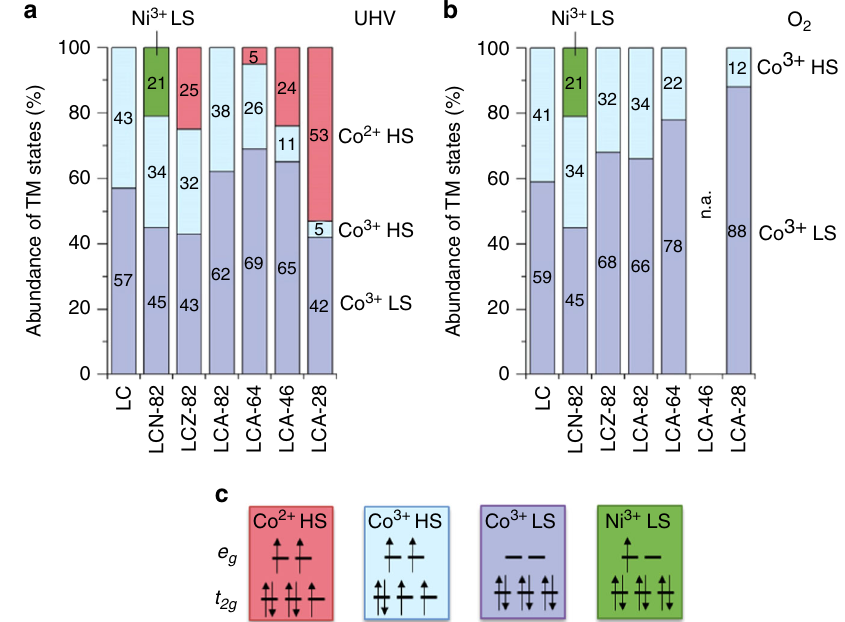
Fig. 1 Abundance of transition metal oxidation and spin states. Abundance of transition metal (TM) states as derived from X-ray absorption spectroscopy at the Co L 2,3 -edges at 623 K ( a ) in ultrahigh vacuum (UHV) and ( b ) in 0.37 kPa O 2 . c Electronic con fi guration of TM 3 d orbitals of abundant, relevant electronic states. Spin states are denoted for high-spin (HS) and low-spin (LS)